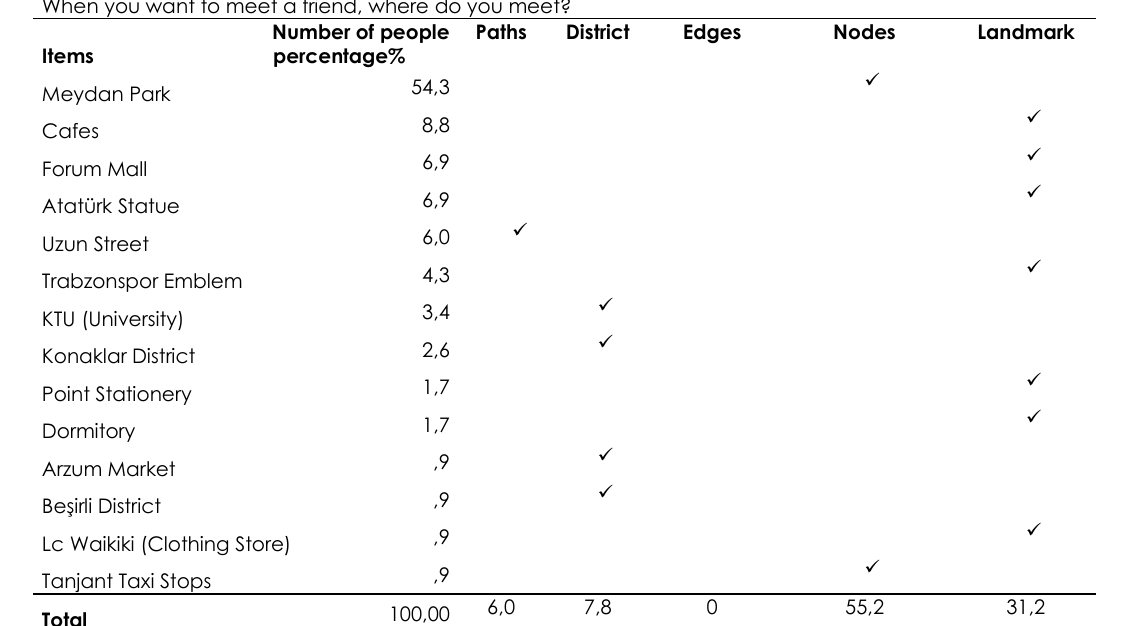
Table 3. Percentage (%) distribution of the participants’ meeting point